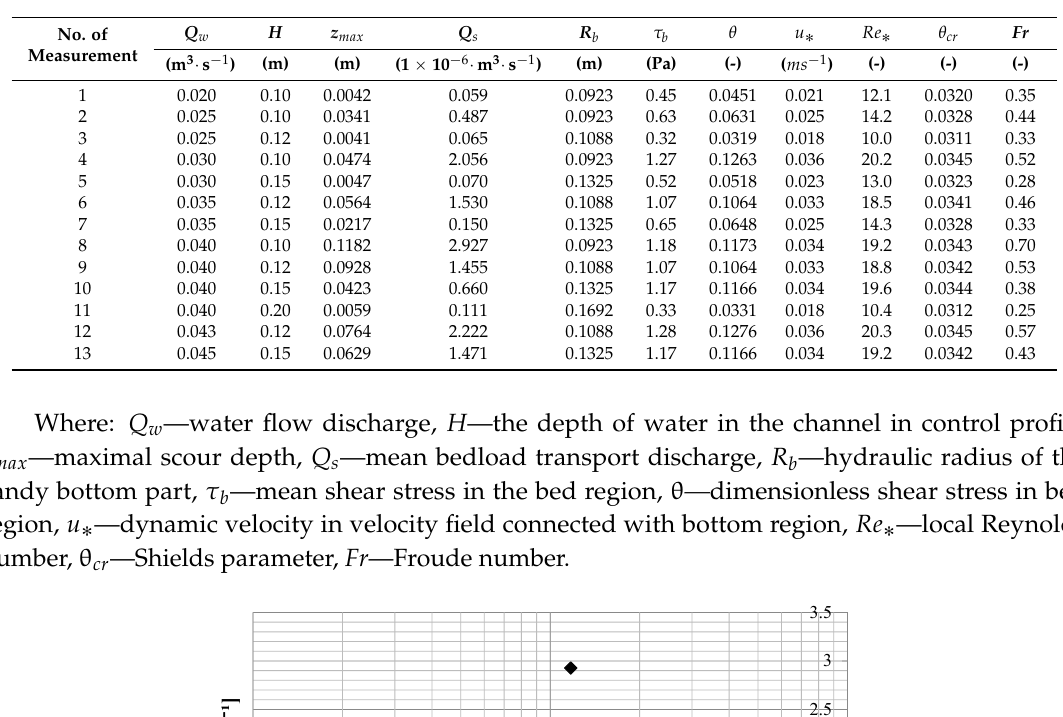
Table 3. Summary of calculated parameters, connected with hydraulic conditions and sediment properties.